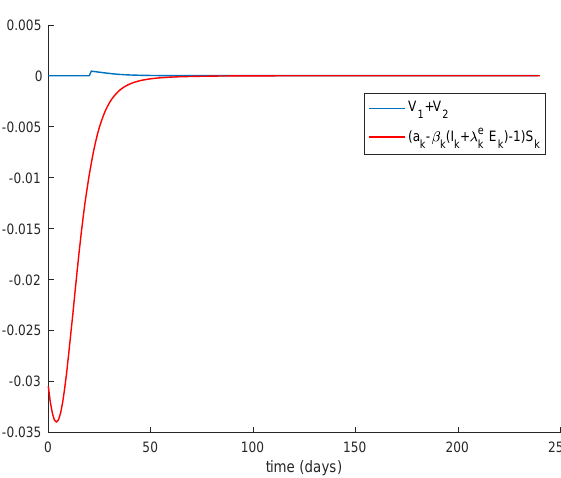
Figure 10. Satisfaction of Condition 3 from Theorem 3.